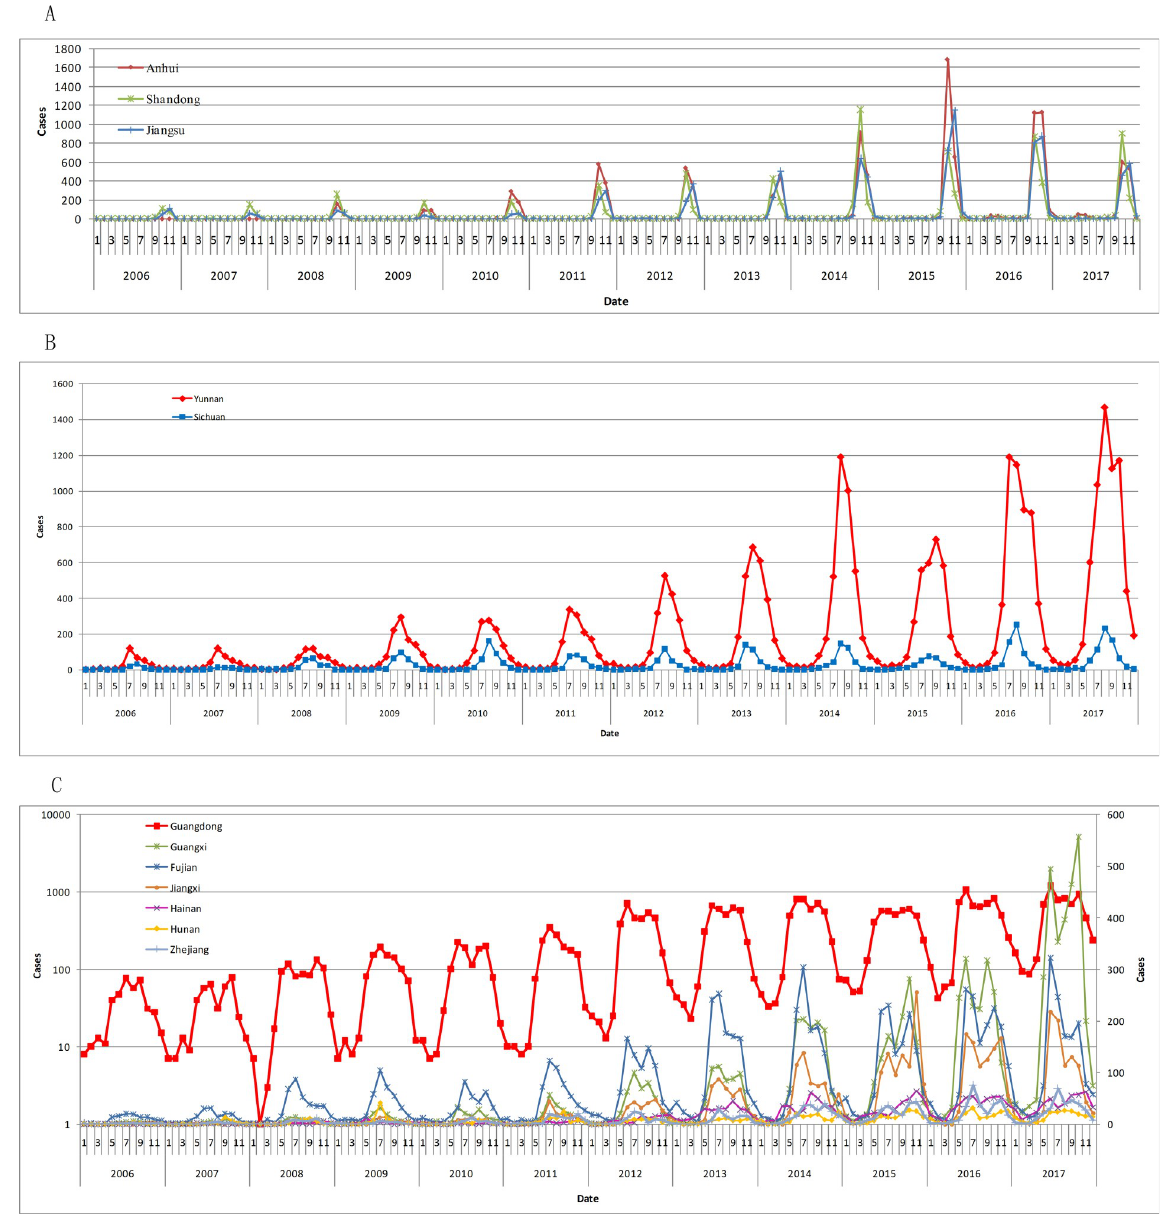
Fig 8. Time-series analyses of scrub typhus in key regions in 2006–2017. A. North region. B. Southwest region B. C. South